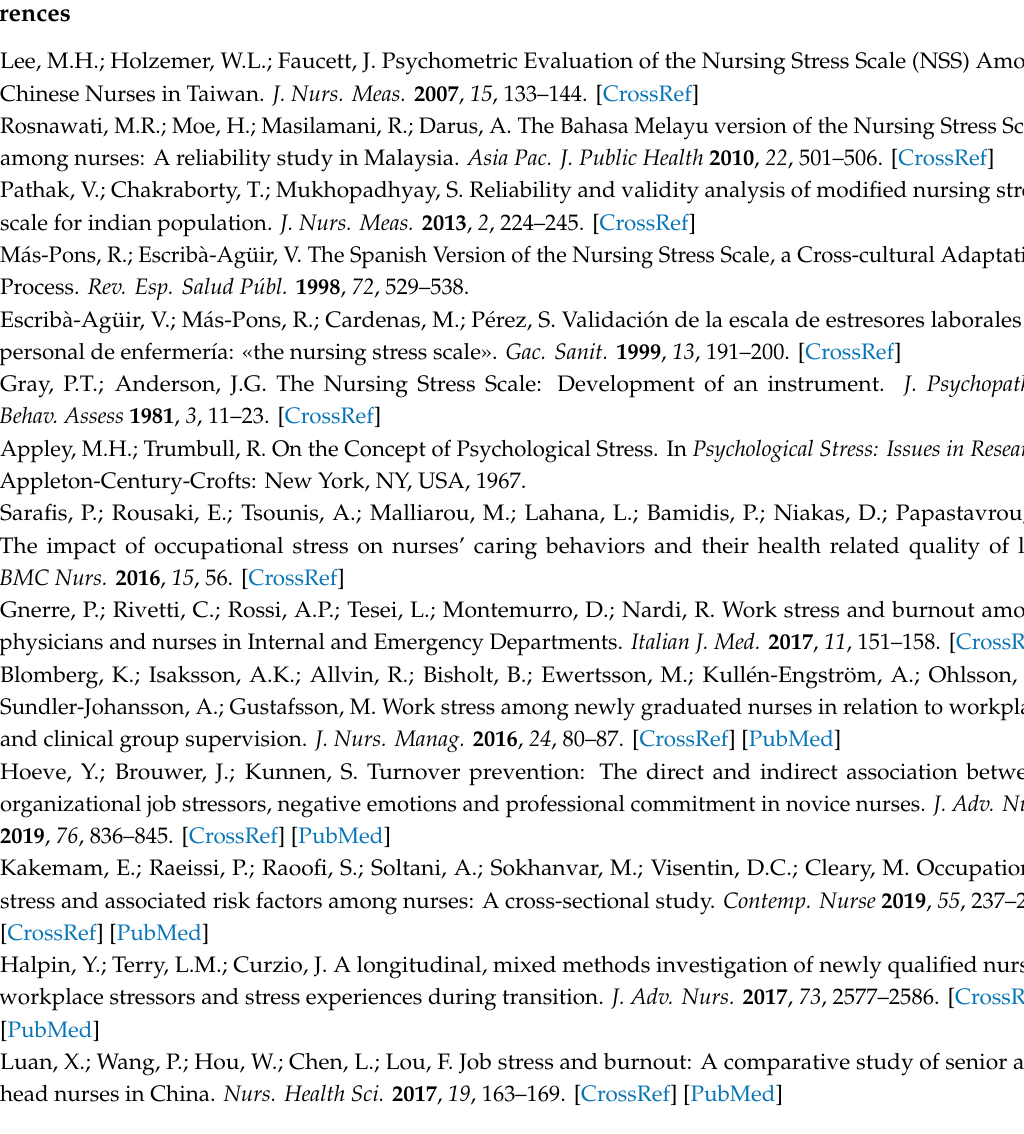
Table S1: Reporting Guideline Checklist. COSMIN